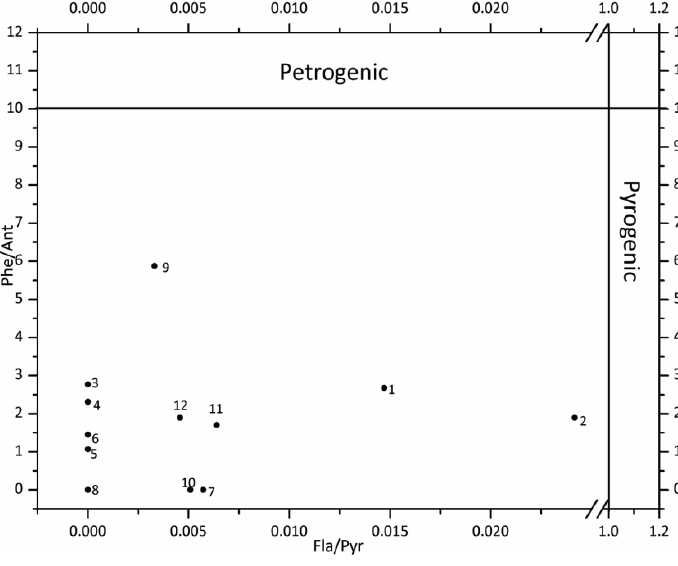
Figure 3. The cross-plots of 16 PAHs for the ratios of Phe/Ant vs.